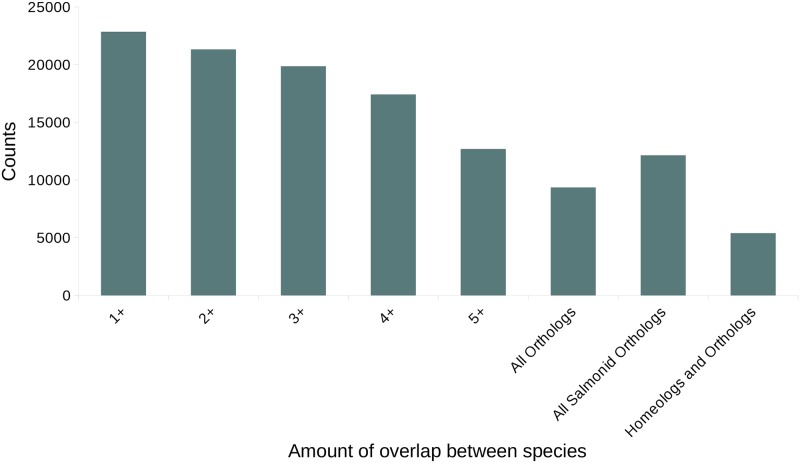
Overlapping orthologs and homeologs between species.A histogram of the number of species with a specific ortholog. If an ortholog was found in all species (including homeologs), it would be in the ‘Homeologs and Orthologs’ column. If an ortholog/homeolog was found in four species, it would be in the 4+ column and all prior columns. The ‘All Orthologs’ column contains only the overlapping orthologs (without regards to overlap with a homeolog) of all the species in this study. Likewise, the ‘All Salmonid Orthologs’ column contains the count of overlapping orthologs (and not homeologs) in only the salmonid species (Arctic charr, rainbow trout, coho salmon, Chinook salmon, and Atlantic salmon).